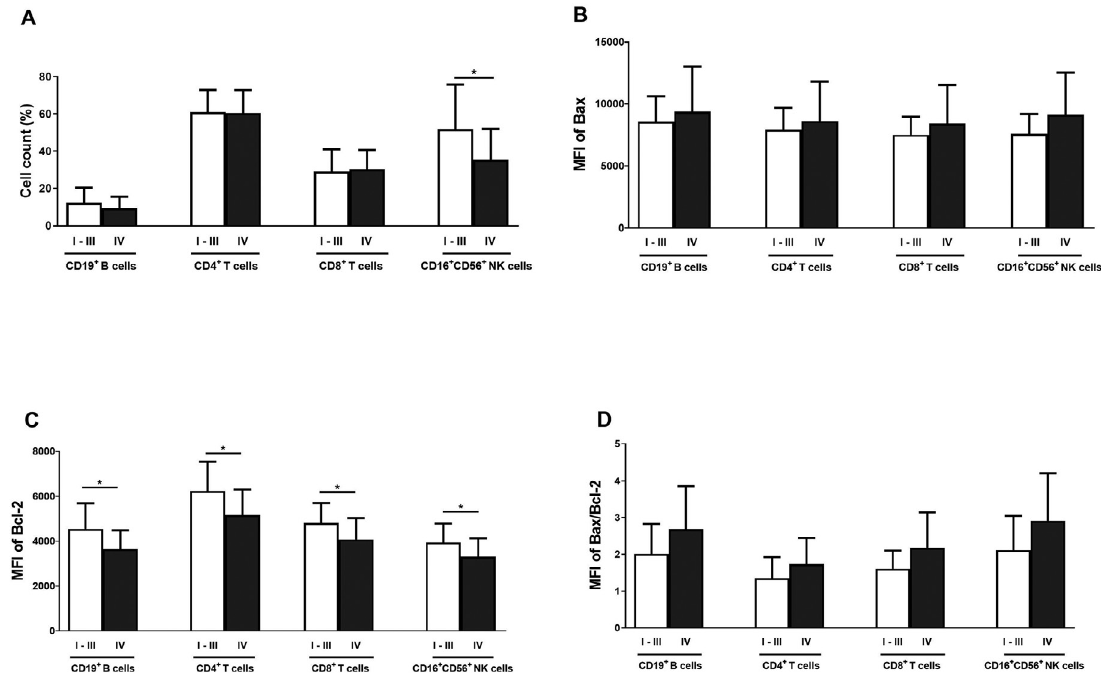
Figure 4- Comparison between stage I–III and stage IV OC samples. Frequency of lymphocyte subsets (A) and MFI of Bax (B), Bcl-2 (C), and Bax/Bcl-2 ratio (D) of the four lymphocyte cell types. *: p